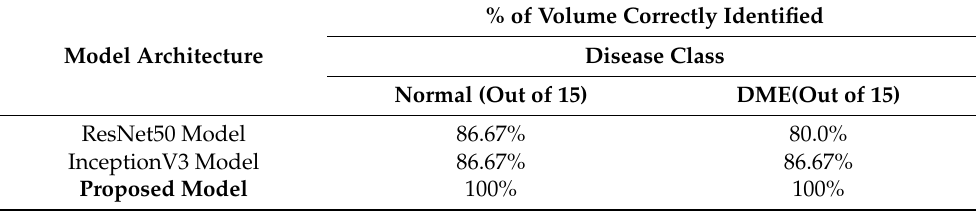
Table 4. Comparison with other models using DHU